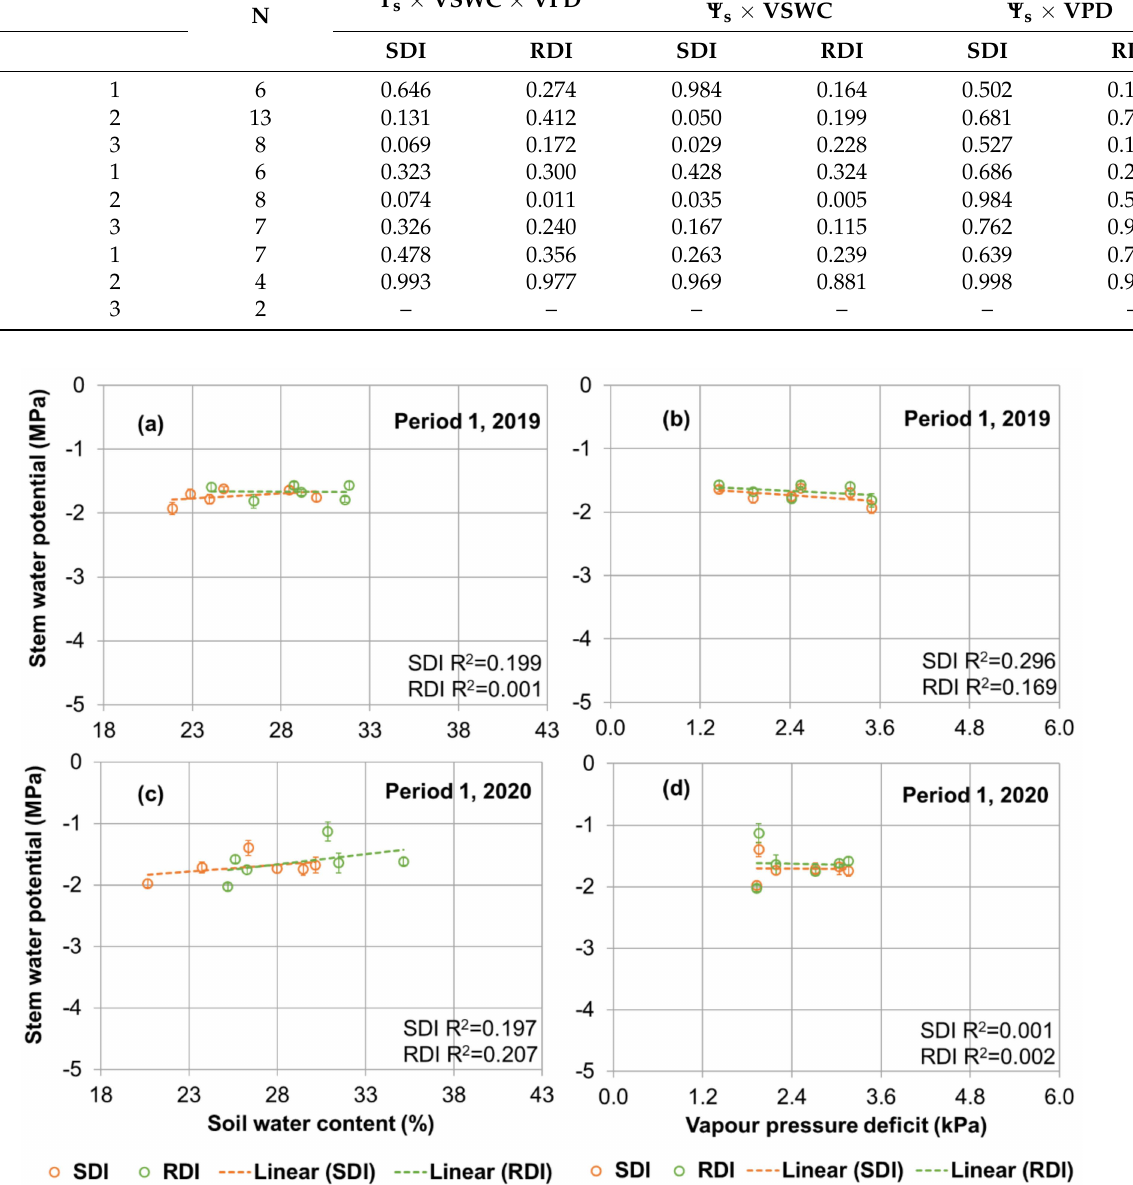
Figure 3. Average stem water potential of five replicate plots in sustained (SDI) and regulated (RDI) deficit irrigation treatments in relation to soil water content (six trees per treatment) and vapour pressure deficit for Period 1 during 2019 ( a , b ) and 2020 ( c , d ). Error bars indicate standard